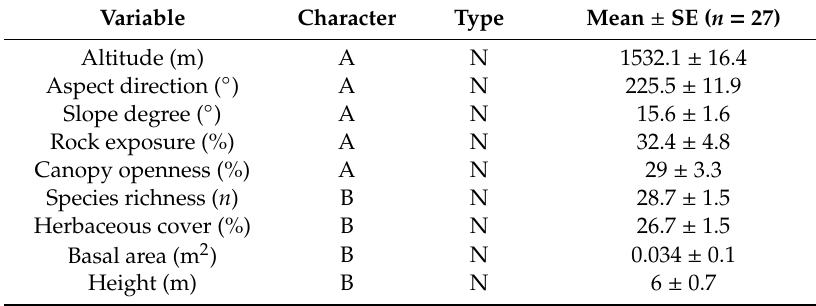
Table 1. Description of the variables used in the R 3.5.1. The character of variables is denoted by A = abiotic, B = biotic; and the type by N = numeric. SE = standard error.